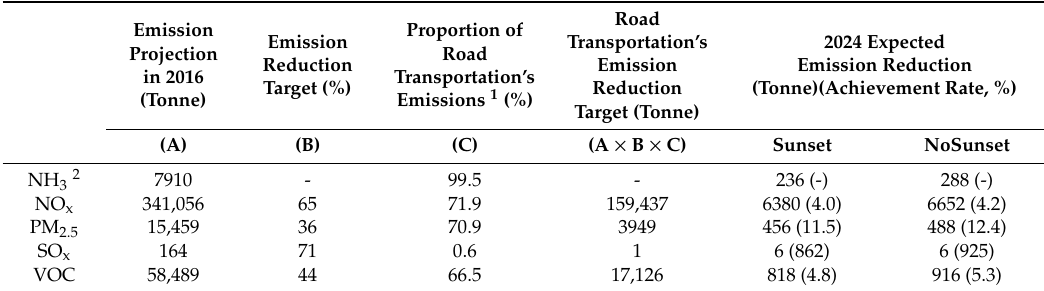
Figure 7. Emission reductions compared to emissions in REF (each scenario minus REF). Note: The values above the bars represent the percentage of emission reductions compared to REF. Table 6. Expected emission reductions in 2024 compared to 2016.